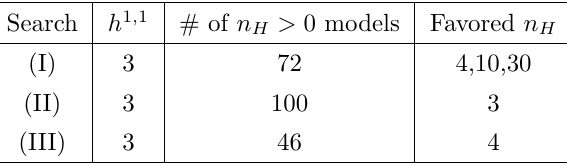
Table 5 . Favored number of Higgs pairs n H except n H = 0 in the 3-generation